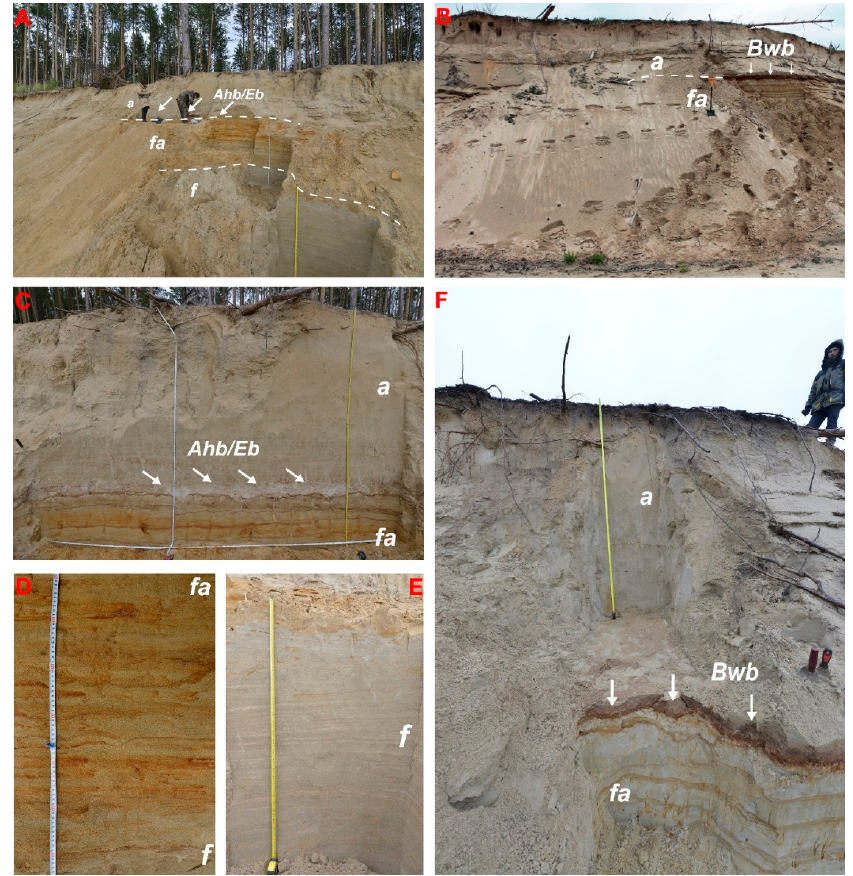
Figure 4 . Fluvio-aeolian successions and sedimentary features ( a —aeolian unit, fa —fluvio-aeolian unit, f— fluvial unit): ( A ) section 1; ( B ) section 2; ( C ) aeolian unit with Usselo-like paleosol, section 1; ( D ) fluvio-aeolian unit, section 1; ( E ) fluvial unit, section 1; ( F ) Finow-like paleosol on the contact of aeolian and fluvio-aeolian units in section 2.